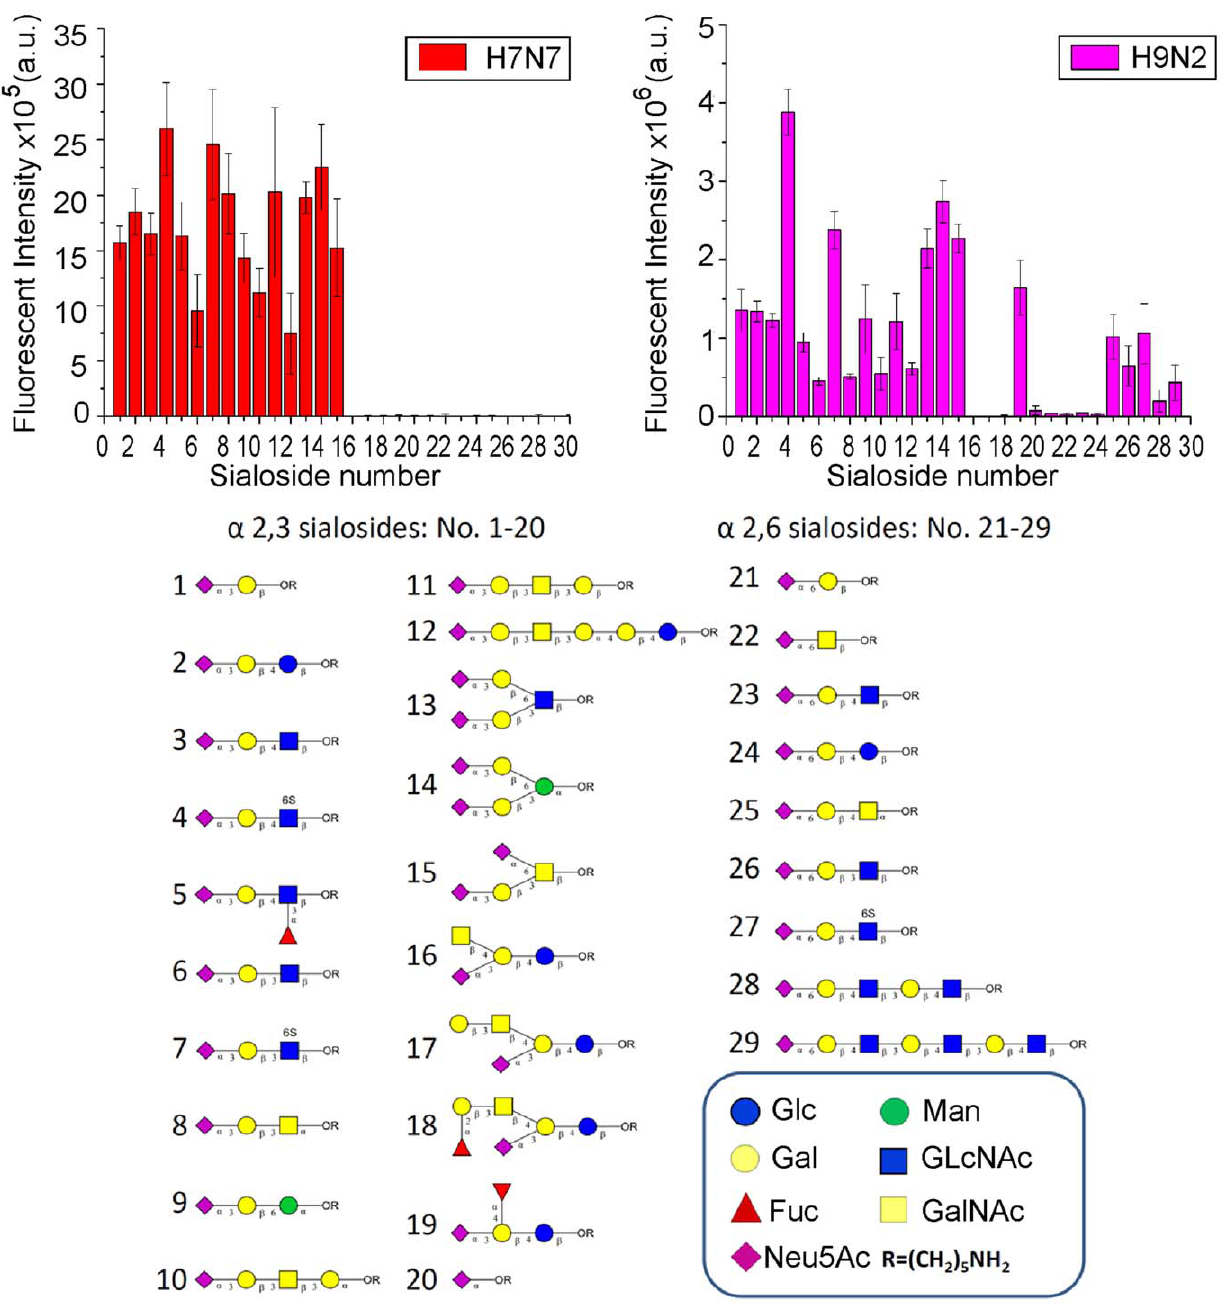
Figure 4. Glycan array analysis. Avian influenza virus (H9N2 and H7N7 subtypes) were subjected to glycan array analysis.